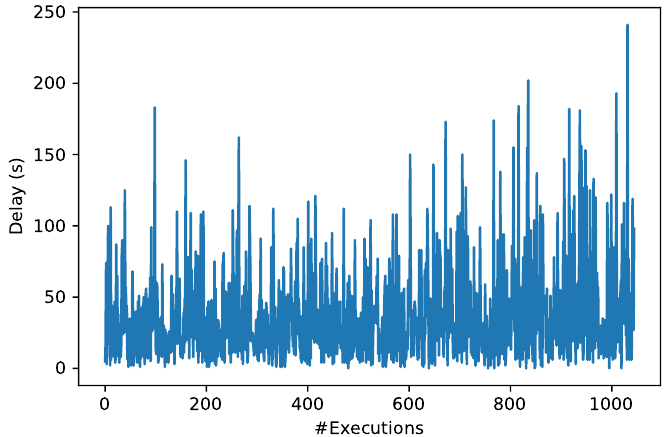
Figure 16. Ropsten testnet time response when executing smart